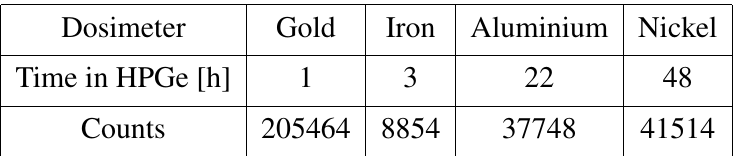
Table 2: Counts in the reaction peak for the different